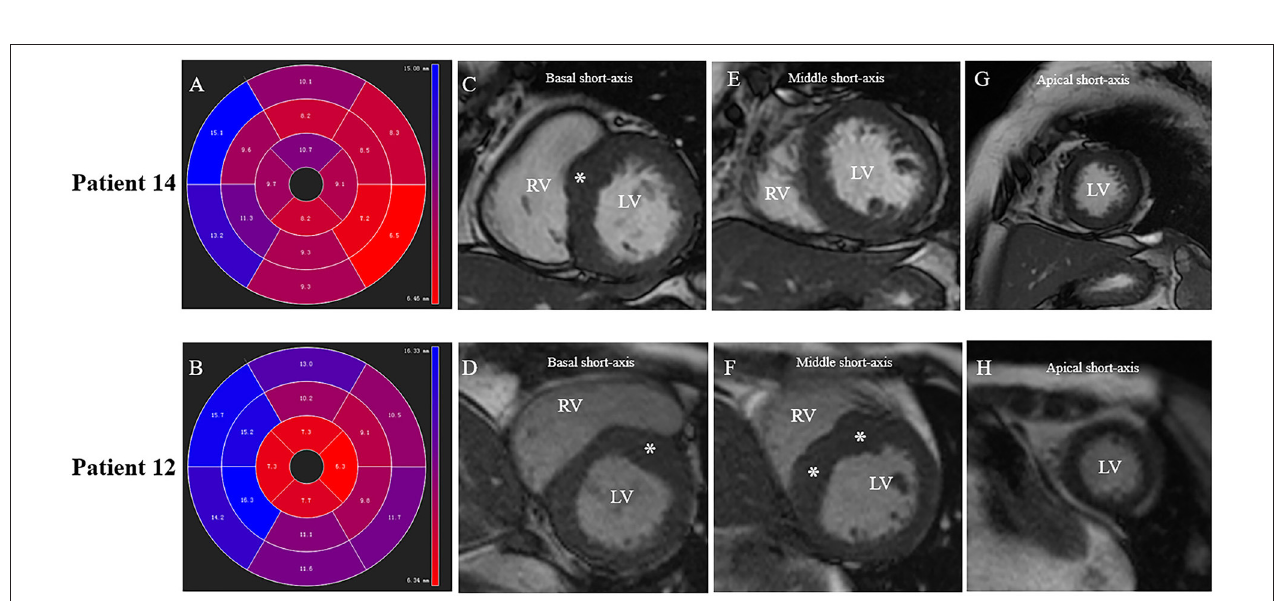
FIGURE 3 | Morphologic abnormalities of mitral valve contributing to outflow tract obstruction. (A,B) The length of the AML was measured by echocardiography in diastole on the apical three-chamber view. (C) Extraordinarily long anterior mitral valve leaflet on CMR. (D) On live ICE screen, the AML (white arrow) is reflexed and attached to IVS during systole and pats on the ablation catheter tip during procedure. AML, anterior mitral leaflet.